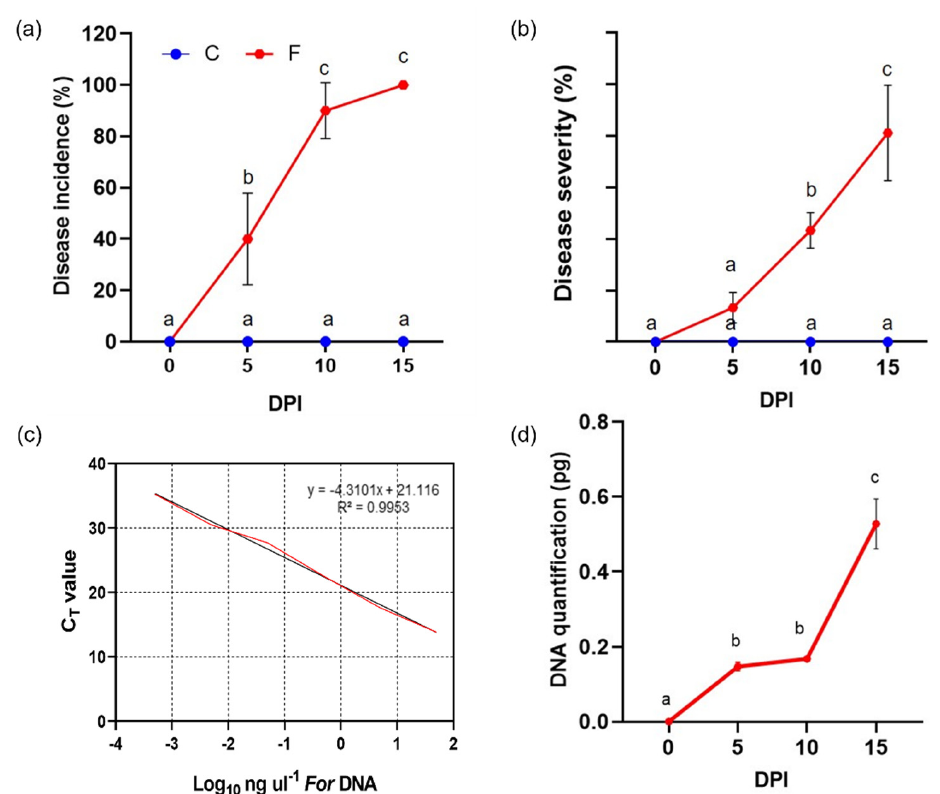
Figure 1. Photographs of healthy versus FOR-infected potted plants during the experimental time course at 5, 10, and 15 dpi to follow the progression of Fusarium wilting.